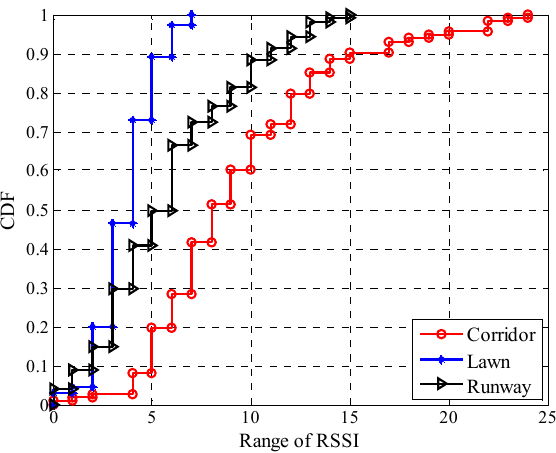
Figure 9. Cumulative distribution functions (CDFs) of the fluctuation range of RSSI in different environments.